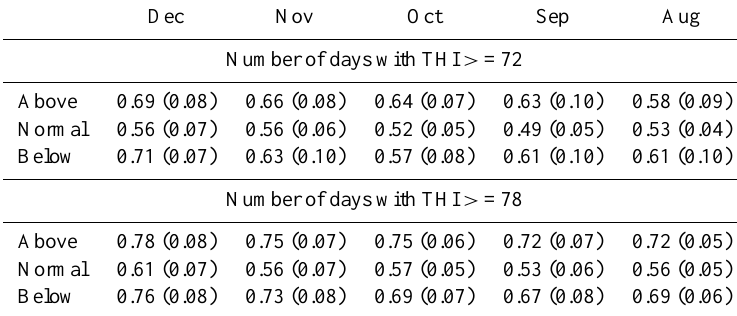
Table 2. As Table 1 but for the number of days with THI > =72 and THI >